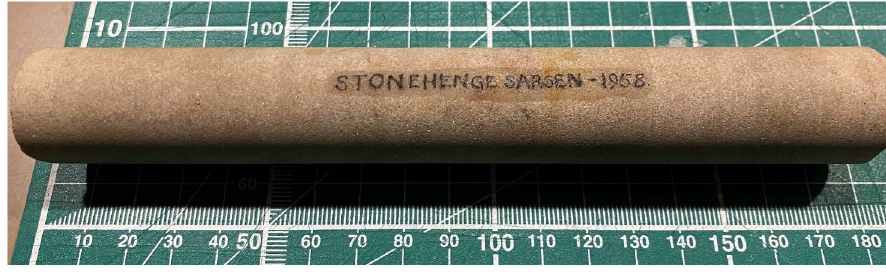
Fig 8. The Salisbury Museum Core from Stone 58 at Stonehenge. This image is reproduced under a CC BY 4.0 license, with permission from David J. Nash, original copyright